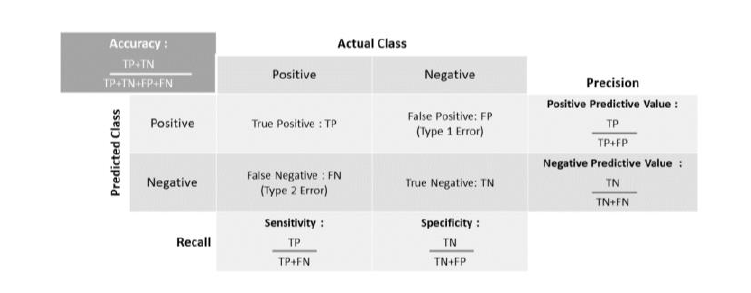
Fig. 5. The confusion matrix in classification